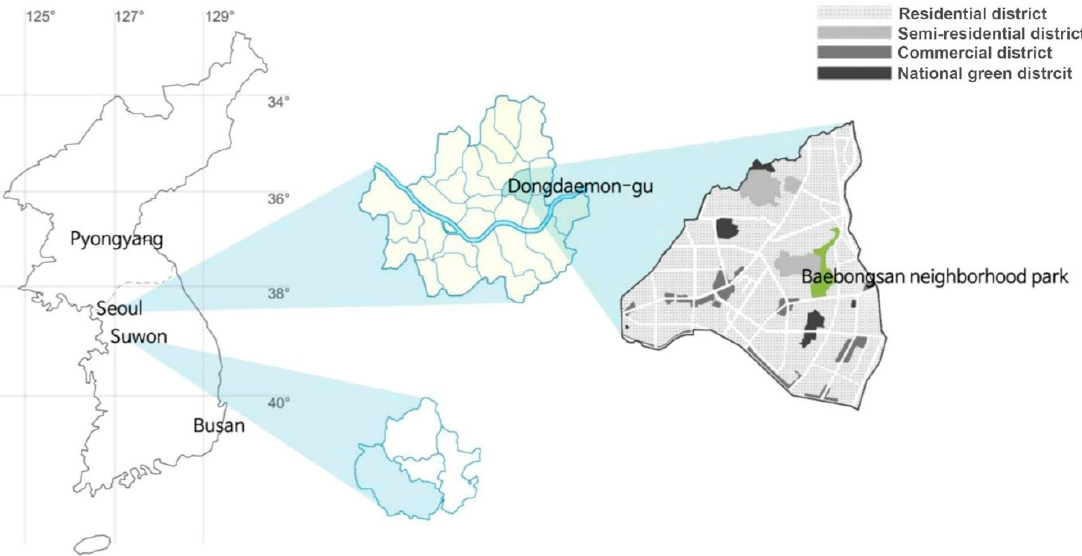
Figure 1. Location of the experimental site (Baebongsan Neighborhood Park and Suwon) and land use of surrounded areas. Baebongsan Neighborhood Park is located in northeast Seoul, Korea, and is surrounded by a residential district.